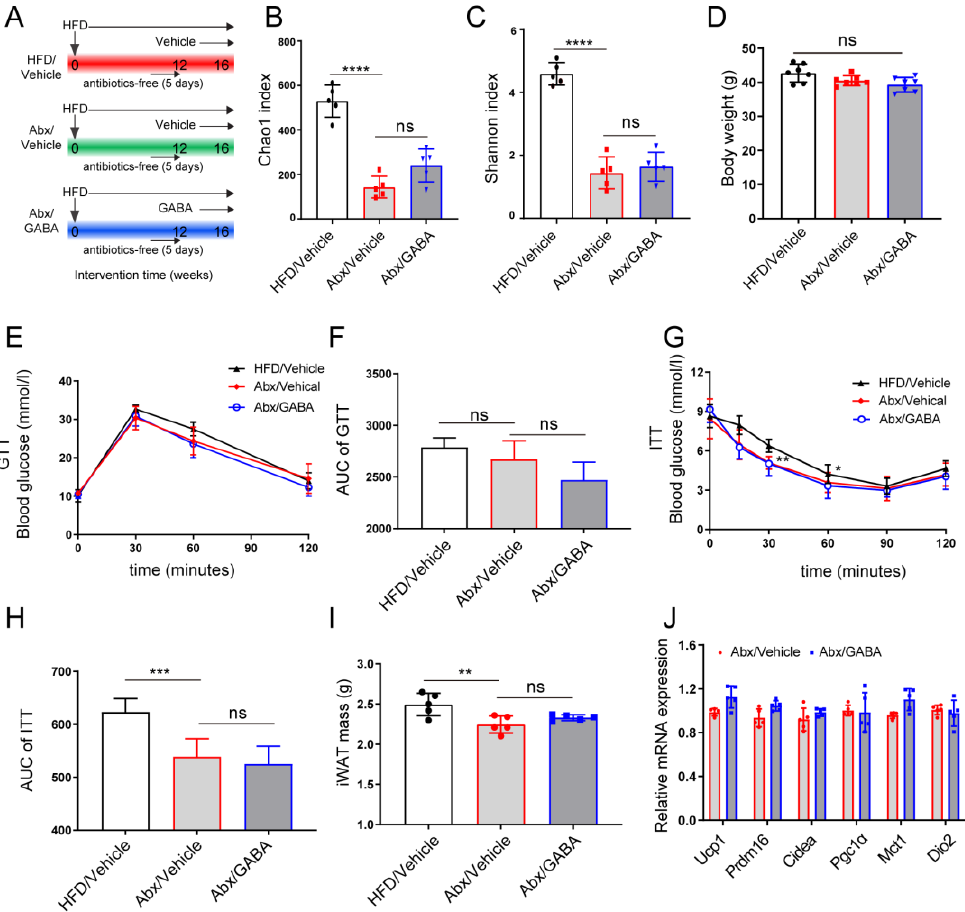
Figure 5. Gut microbiota mediates the effect of GABA on the beiging of iWAT. Intestinal microbiota- free HFD-fed mice were treated daily with the vehicle or GABA for 4 weeks. ( A ) Flow chart of animal experiments. ( B , C ) Gut microbiota richness, as indicated by the Chao1 and Shannon indices. ( D ) Body weight after the experiment. ( E , F ) GTT curve and the AUC analysis. ( G , H ) ITT curve and the AUC analysis. ( I ) Tissue weights of iWAT. ( J ) Expression of thermogenic genes (including Ucp1, Prdm16, Cidea, Pgc1α, Mct1, and Dio2) in the iWAT. Abx, antibiotics. n = 5–7 for all groups. Data are represented as means ± standard deviation and were analyzed by one-way or two-way ANOVA. Ns, not significant. ** p < 0.01, *** p < 0.001 and **** p < 0.0001. GABA, Gamma-aminobutyric acid; HFD, high-fat diet; NMDS, non-metric multidimensional scaling; OTU, operational taxonomic unit.